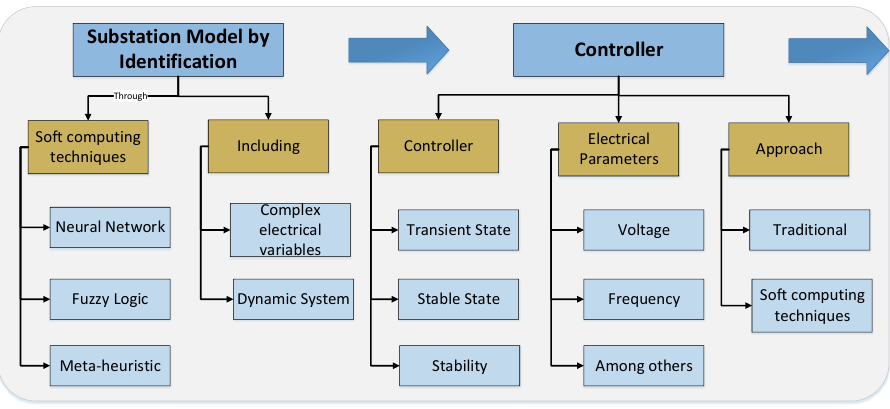
Figure 1. Comparison between a system with centralized and distributed